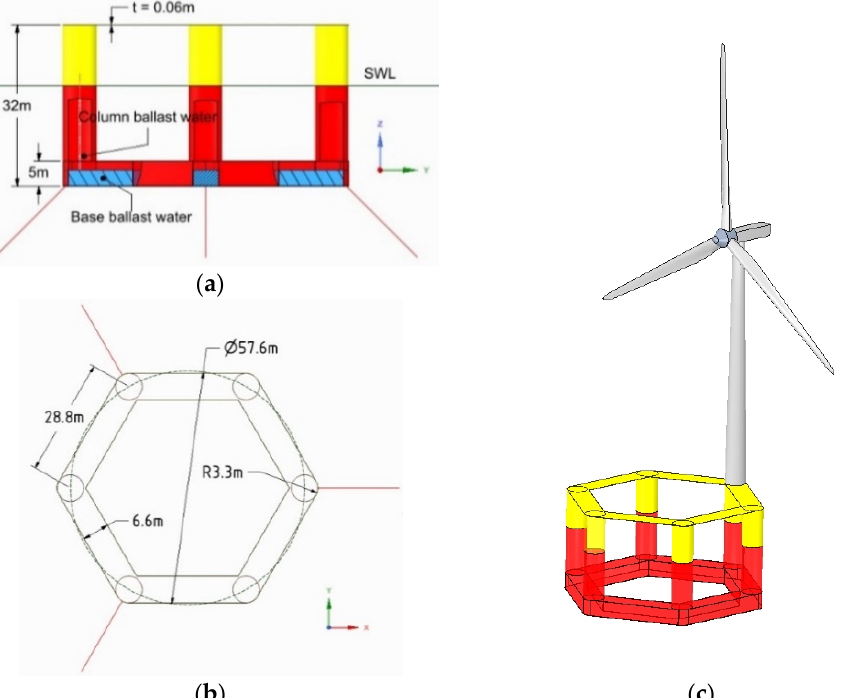
Figure 13. Sketch of six ‐ column platform floating wind turbine system: ( a ) front view of six ‐ column platform; ( b ) top view of six ‐ column platform; ( c ) isometric view of six ‐ column floating wind turbine system.